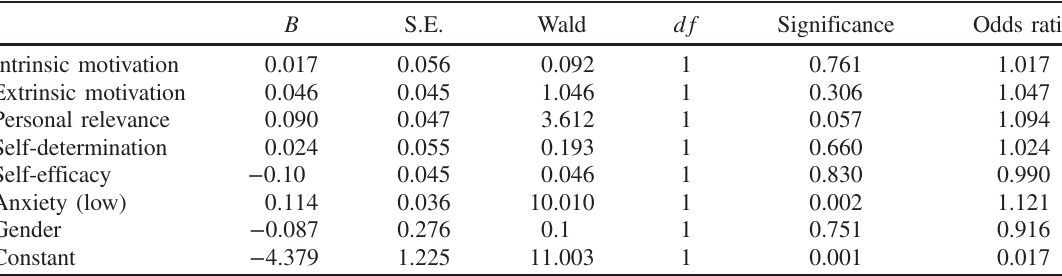
TABLE VII. Motivation impact on consideration to leave. B